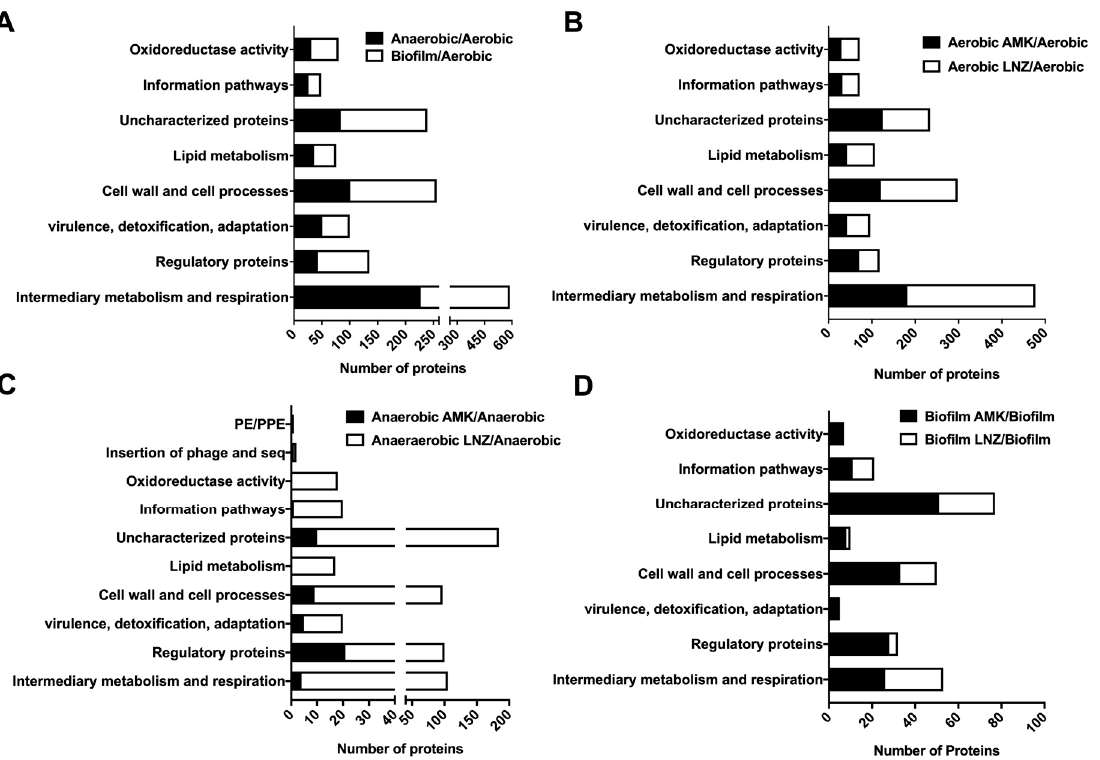
Figure 5. Functional classification of MAB upregulated proteins by ≥ 1.5-fold. Enriched proteins of ( A ) anaerobic and biofilm conditions; ( B ) aerobic condition during exposure to AMK or LNZ; ( C ) anaerobic condition during exposure to AMK or LNZ; and ( D ) biofilm condition during exposure to AMK or LNZ. The analysis was done by finding MAB protein homologs in M. tuberculosis H37Rv strain and using the functional categorization available on TubercuList webserver of Institute Pasteur. MAB proteins that did not show any homology were classified based on predicted or known function for conserved domain / motif search at NCBI (National Center for Biotechnology Information) and the Pfam database through the Sanger Institute. Histograms show number of proteins belonging to each functional category.